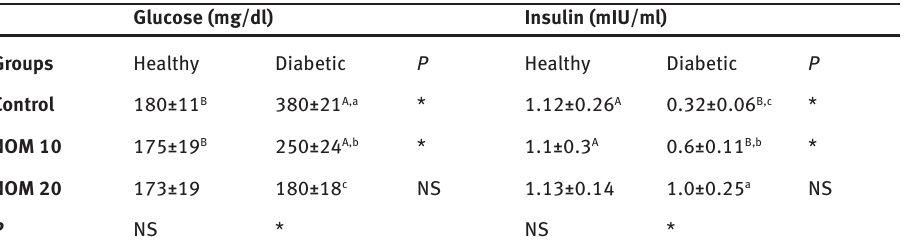
Table 2: Effect of Nannochloropsis oculata microalgae (NOM) at levels of 10 and 20 mg.kg -1 of body weight on the serum concentrations of glucose and insulin in healthy and diabetic rats.